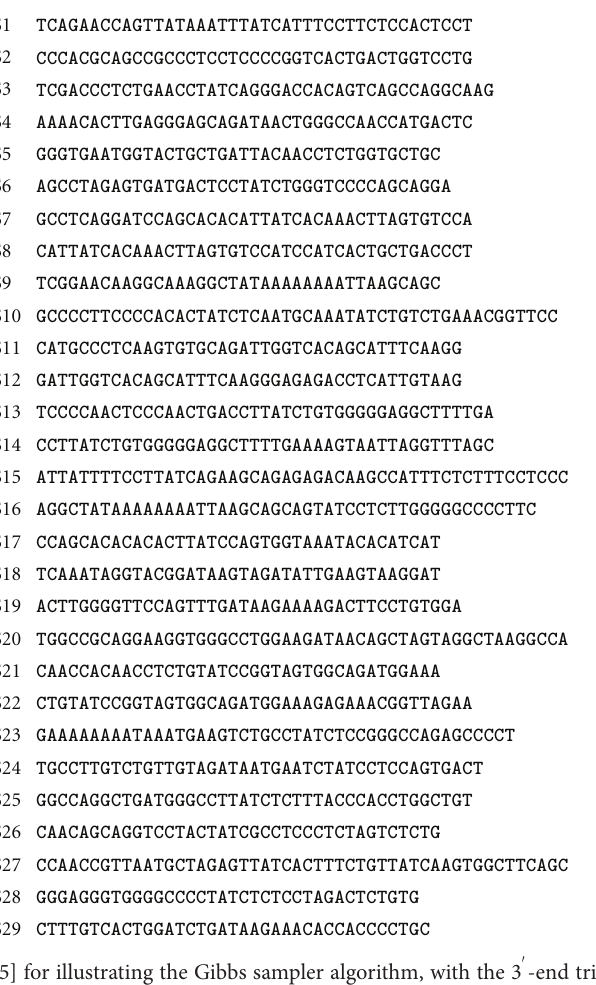
F 2: e erythroid sequences [85] for illustrating the Gibbs sampler algorithm, with the 3 bases to �t the page.